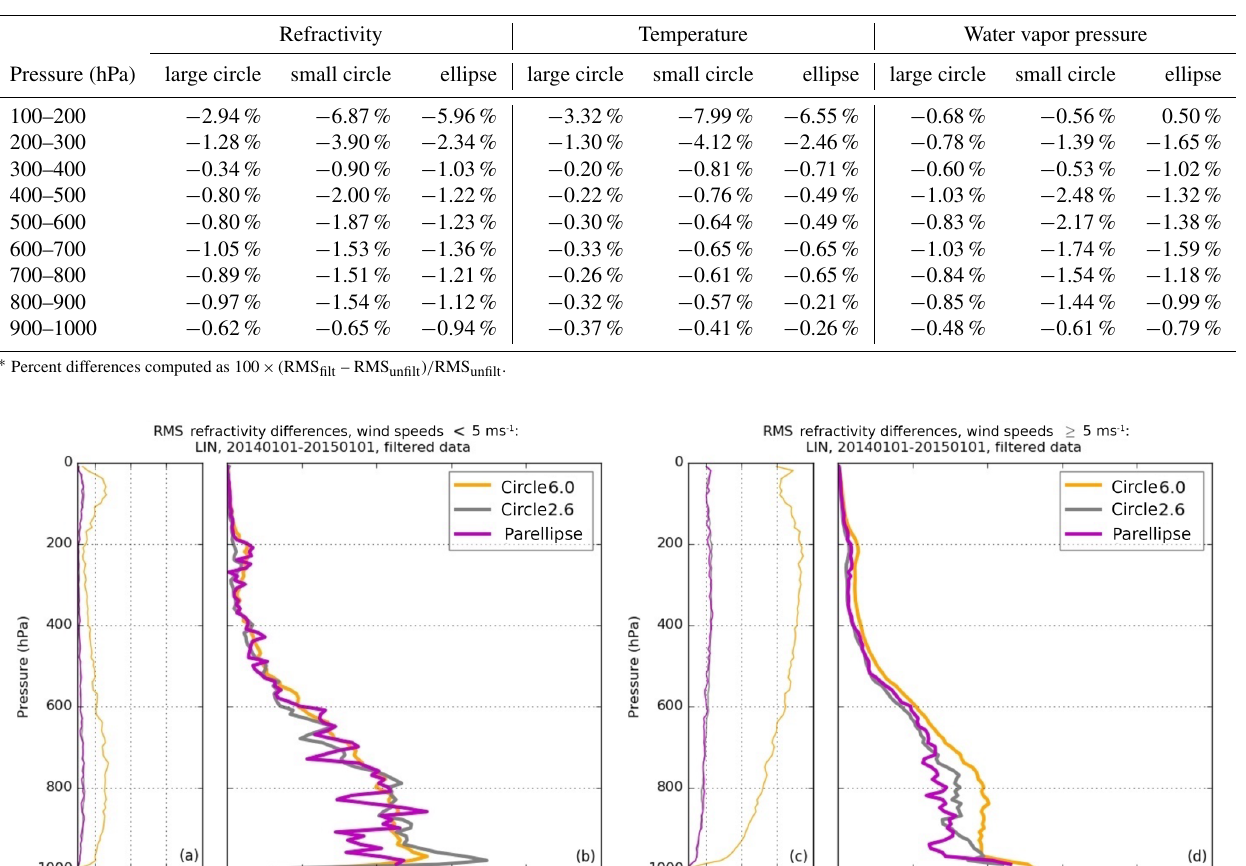
Table 1. Filtered vs. unfiltered RMS percent differences ∗ for refractivity, temperature, and water vapor pressure at Lindenberg, 2014. RMS differences are computed using all co-located pairs within 100hPa pressure layers for the filtered and unfiltered data sets, and then the percent differences between the two are computed and reported here.